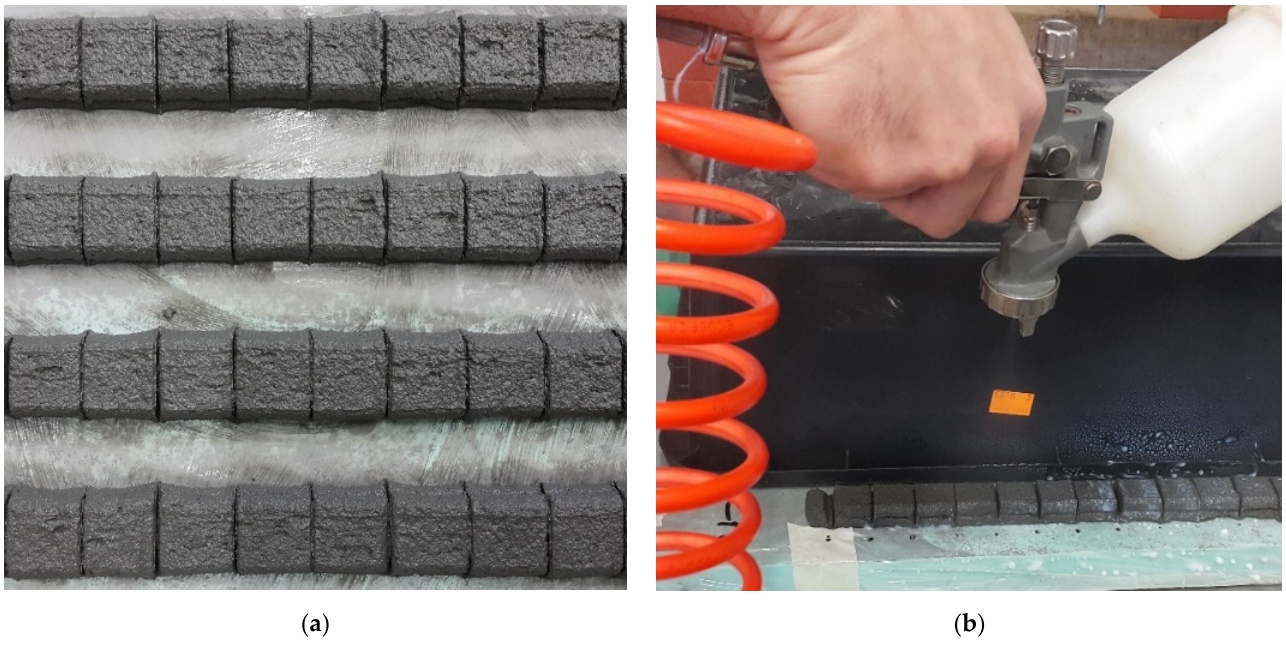
Figure 2. Sample preparation for photocatalytic test: ( a ) the specimens after fresh cutting; ( b ) spraying of TiO 2 aqueous suspension using an atmospheric air compressor spray gun.